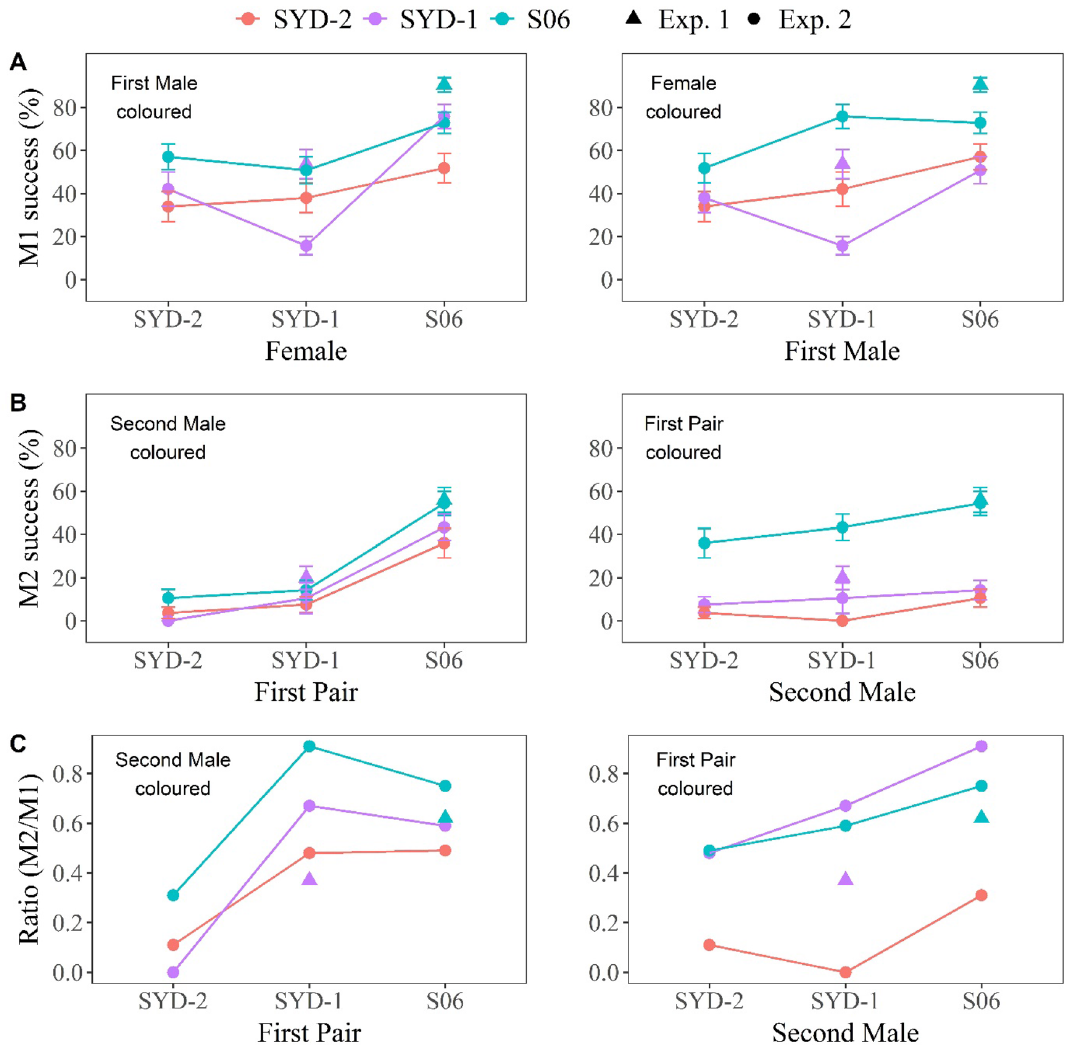
Figure 5. M1%, M2% and M2%/M1% for intra- vs inter-strain pairings, excluding reciprocals. (A) M1% ± standard error (se) for intra- and inter-strain pairings of SYD-2, SYD-1 and S06. (B) M2% ± se for females previously mated in intra-strain M1 pairings of each of those strains with M2 males of each of those strains. (C) M2%/M1% ± se for the females in Panel B. To facilitate visualisation of the effects of each of the different M1 and/or M2 variables, the data for each panel are repeated on two separate graphs, one with each of the other variables on the X axis. Data for the two generations scored have been pooled in all three panels. Where available, results for equivalent pairings and generations from Experiment 1 are also indicated in each panel. Sample sizes for Experiment 2 were 38–68 and 53–81 for intra- and inter-strain pairings respectively for M1 and 35–67 and 19–89 for intra- and inter-strain pairings respectively for M2. Data from Experiments 1 and 2 are shown as triangles and circles